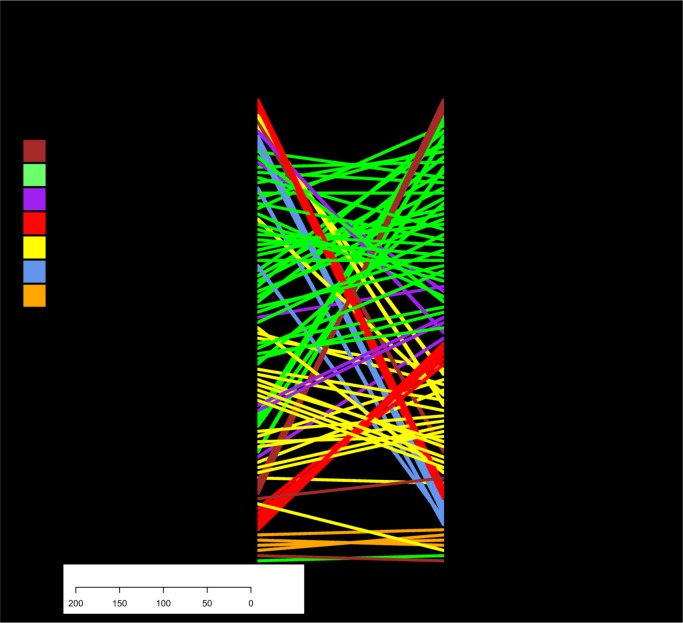
A 15-loci MIRU-VNTR derived neighbour joining tree (right) of 142 strains of the LAM clade (lineage 4) for which both whole genome sequence data were available labelled according to Institut Pasteur website www.miru-vntrplus.org and compared to a whole genome sequence neighbour joining tree (left) demonstrating the misclassification of strains into groups at high definition based on MIRU alone.